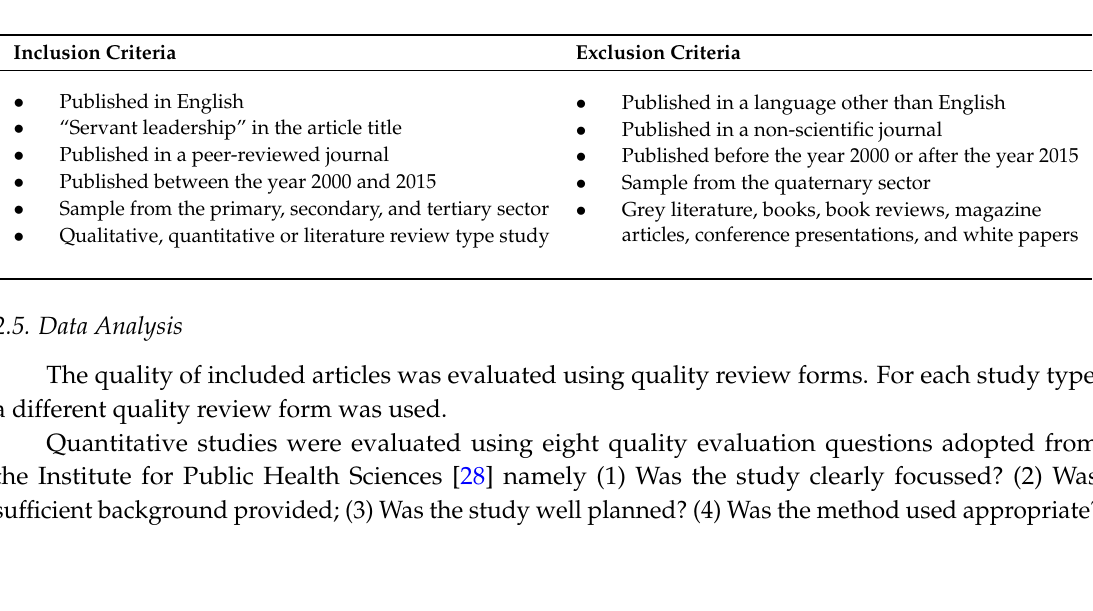
Table 2. Inclusion and exclusion